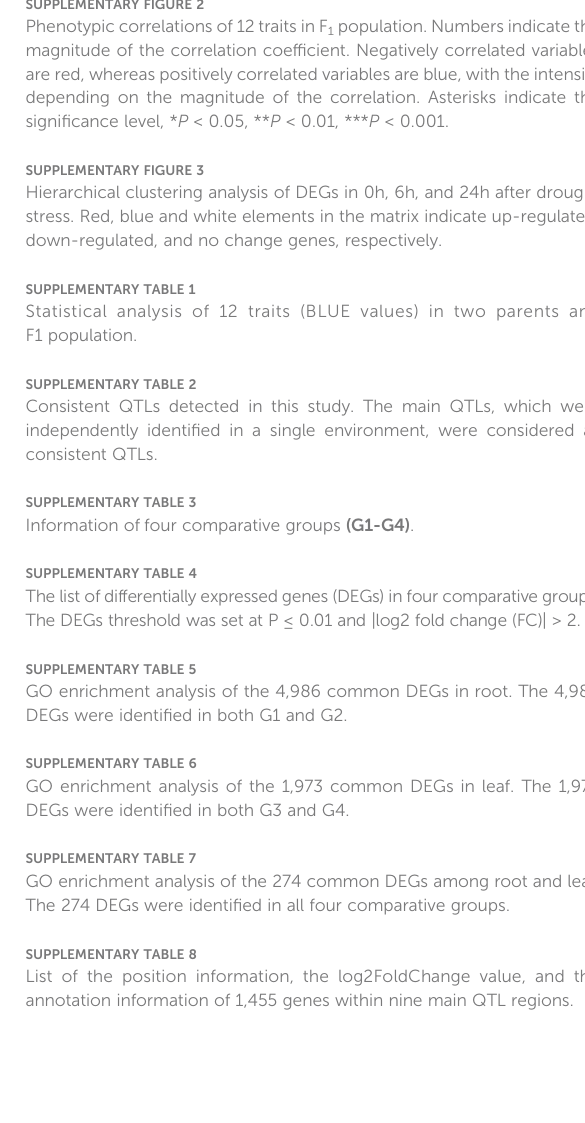
SUPPLEMENTARY FIGURE 1 Frequency distributions of best linear unbiased estimation (BLUE) values of 12 phenotypic data in the F 1